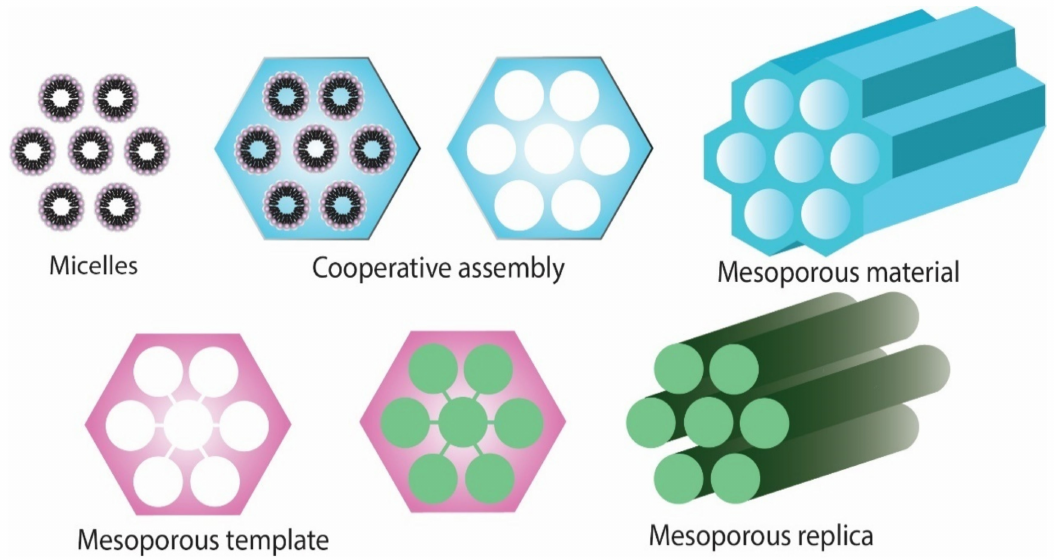
Figure 1. Schematic representation of obtaining mesoporous